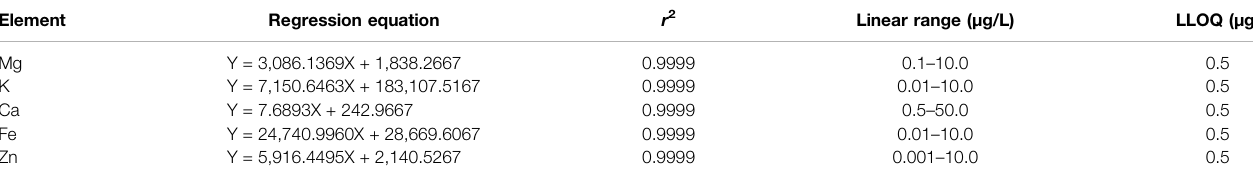
TABLE 1 | Regression equations, correlation coef fi cient, linear range, and LLOD of ICP-MS detection. Element Regression